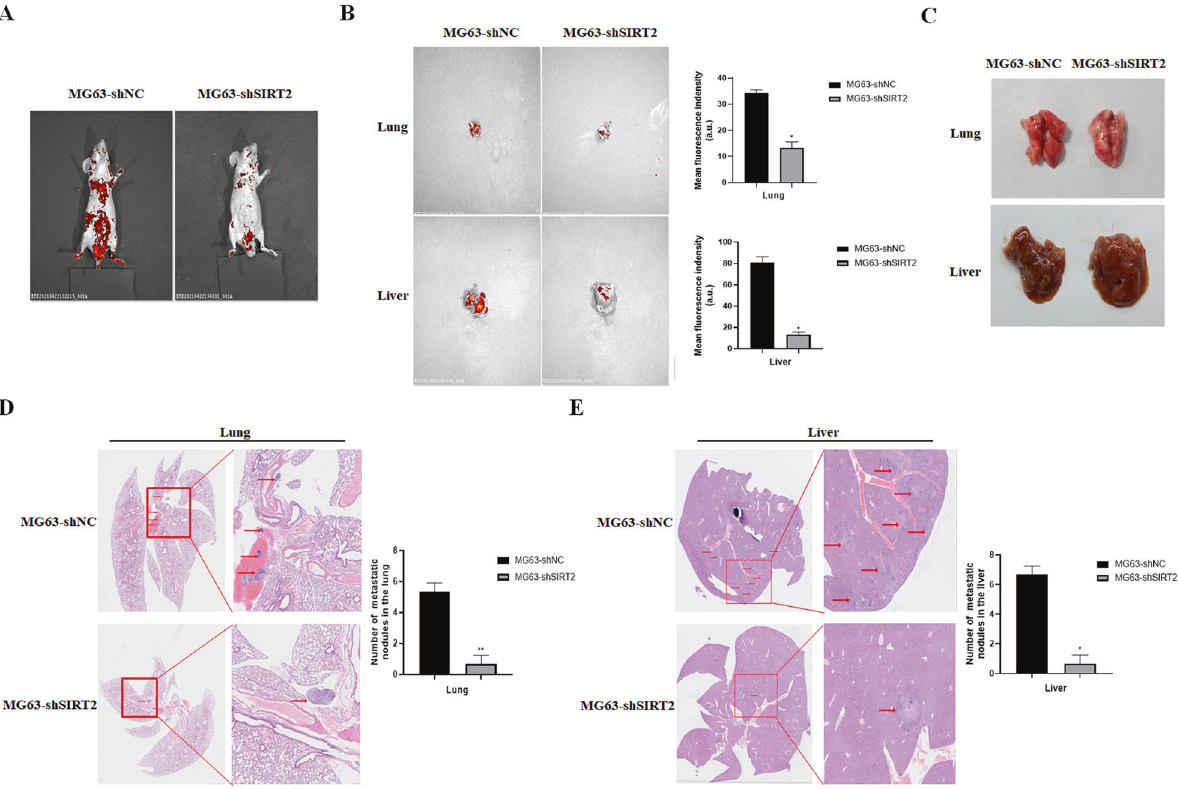
Fig. 6 SIRT2 knockdown inhibited the metastatic ability of osteosarcoma cells in vivo. A Small animal in vivo imager was used to detect the metastasis of osteosarcoma cells in the SIRT2 knockdown group and the control group. B Fluorescence images of the lung and liver in the SIRT2 knockdown group and control group. A representative fl uorescence image of at least three tissue samples is shown. The right panel is the summarized data of immuno fl uorescence density. C Photographs of the lung and liver of the two groups of nude mice. D , E H&E staining of paraf fi n-embedded lung and liver sections. The right panel is a magni fi cation of the rectangle in the left panel, with arrows showing metastatic nodules. Number of metastatic nodules in the lung or liver is summarized in a histogram format. (* P < 0.05, ** P < 0.01).